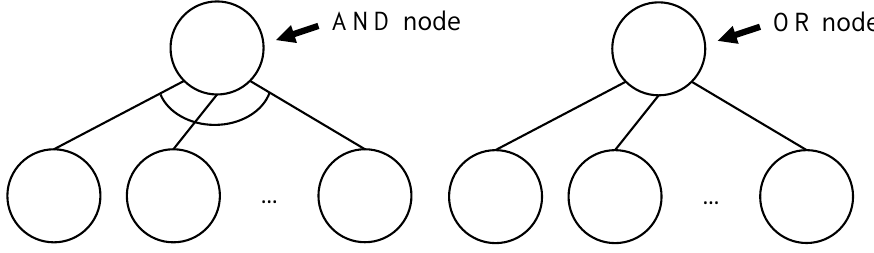
Figure 1. The representation of nodes in an AND/OR